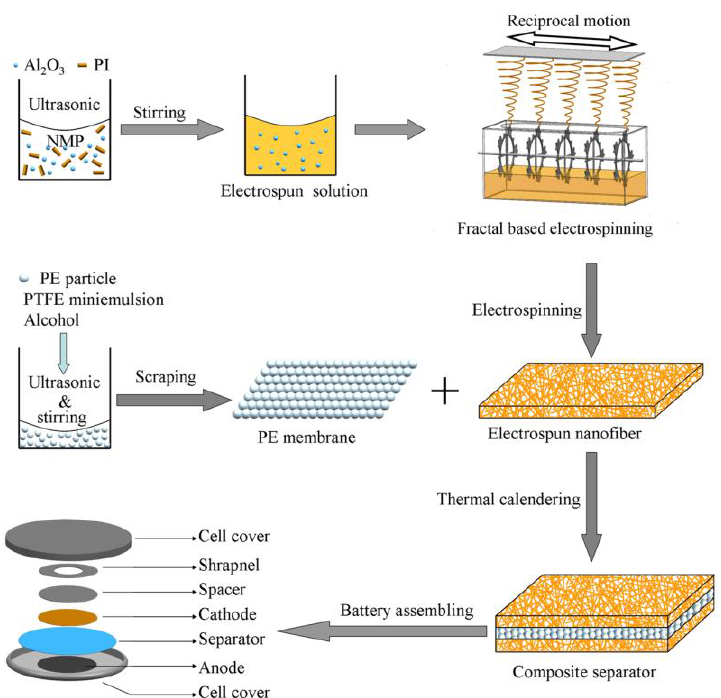
Figure 2. The flowchart of the fabrication of multilayer composite membrane.